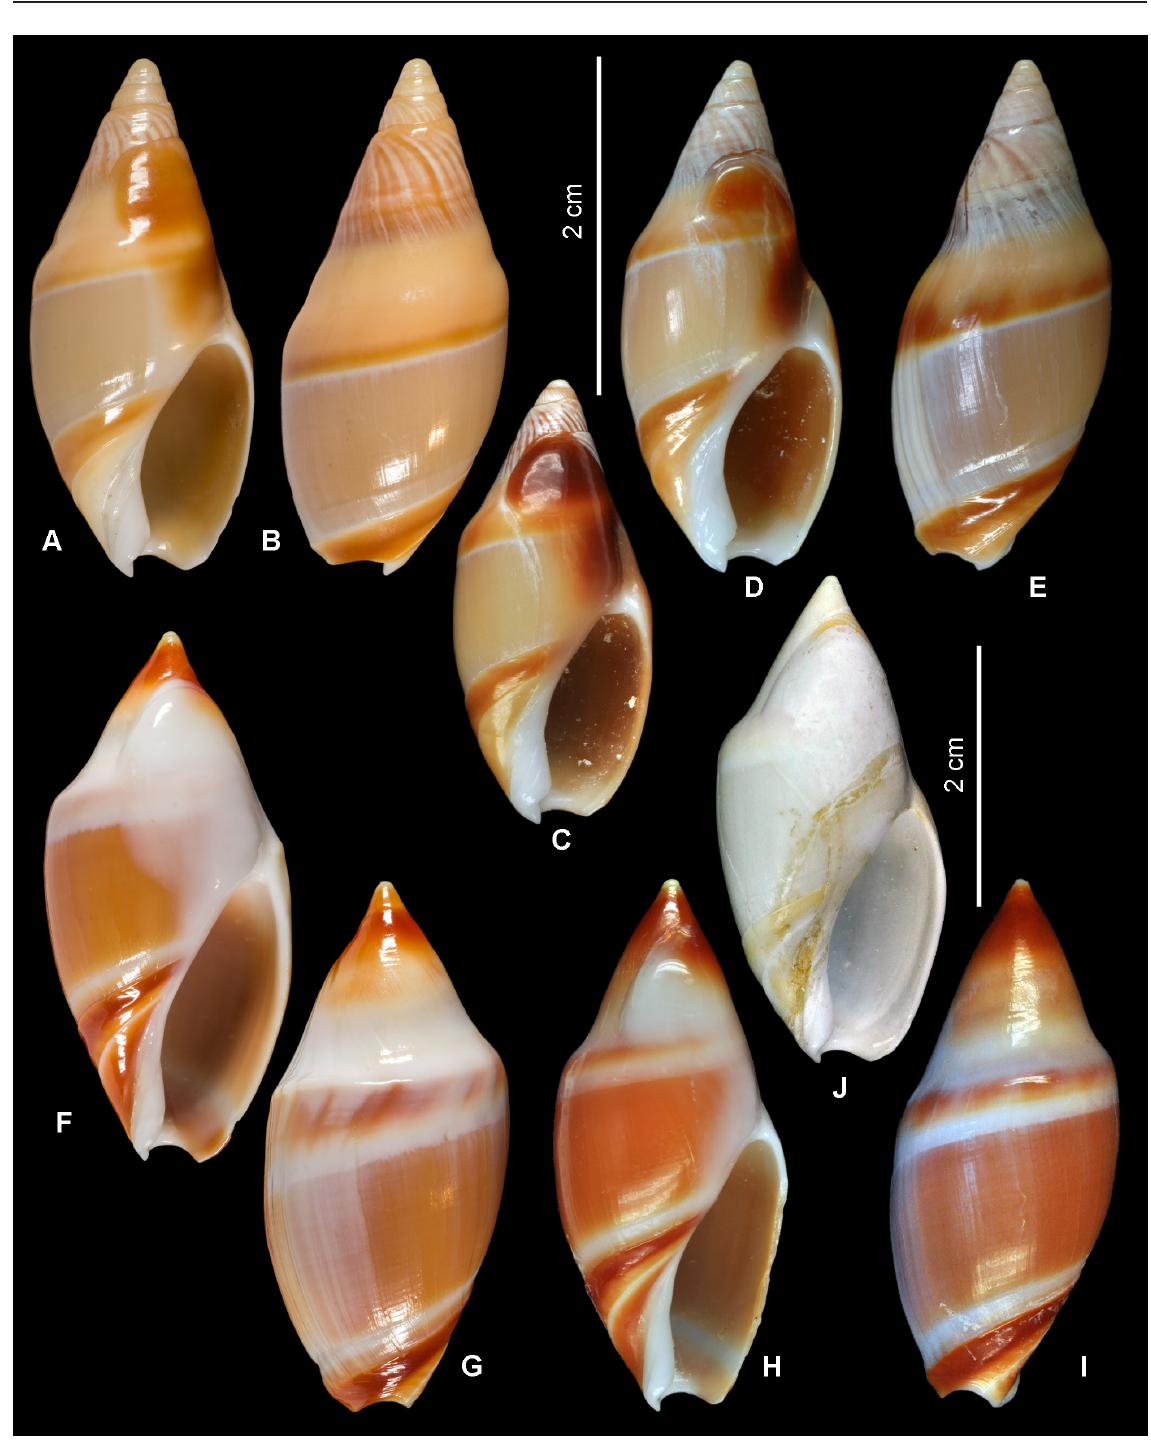
Fig. 18. A–E . A. fuscolingua Kilburn & Bouchet, 1988. A–B . Holotype, MNHN IM-2000-1439,